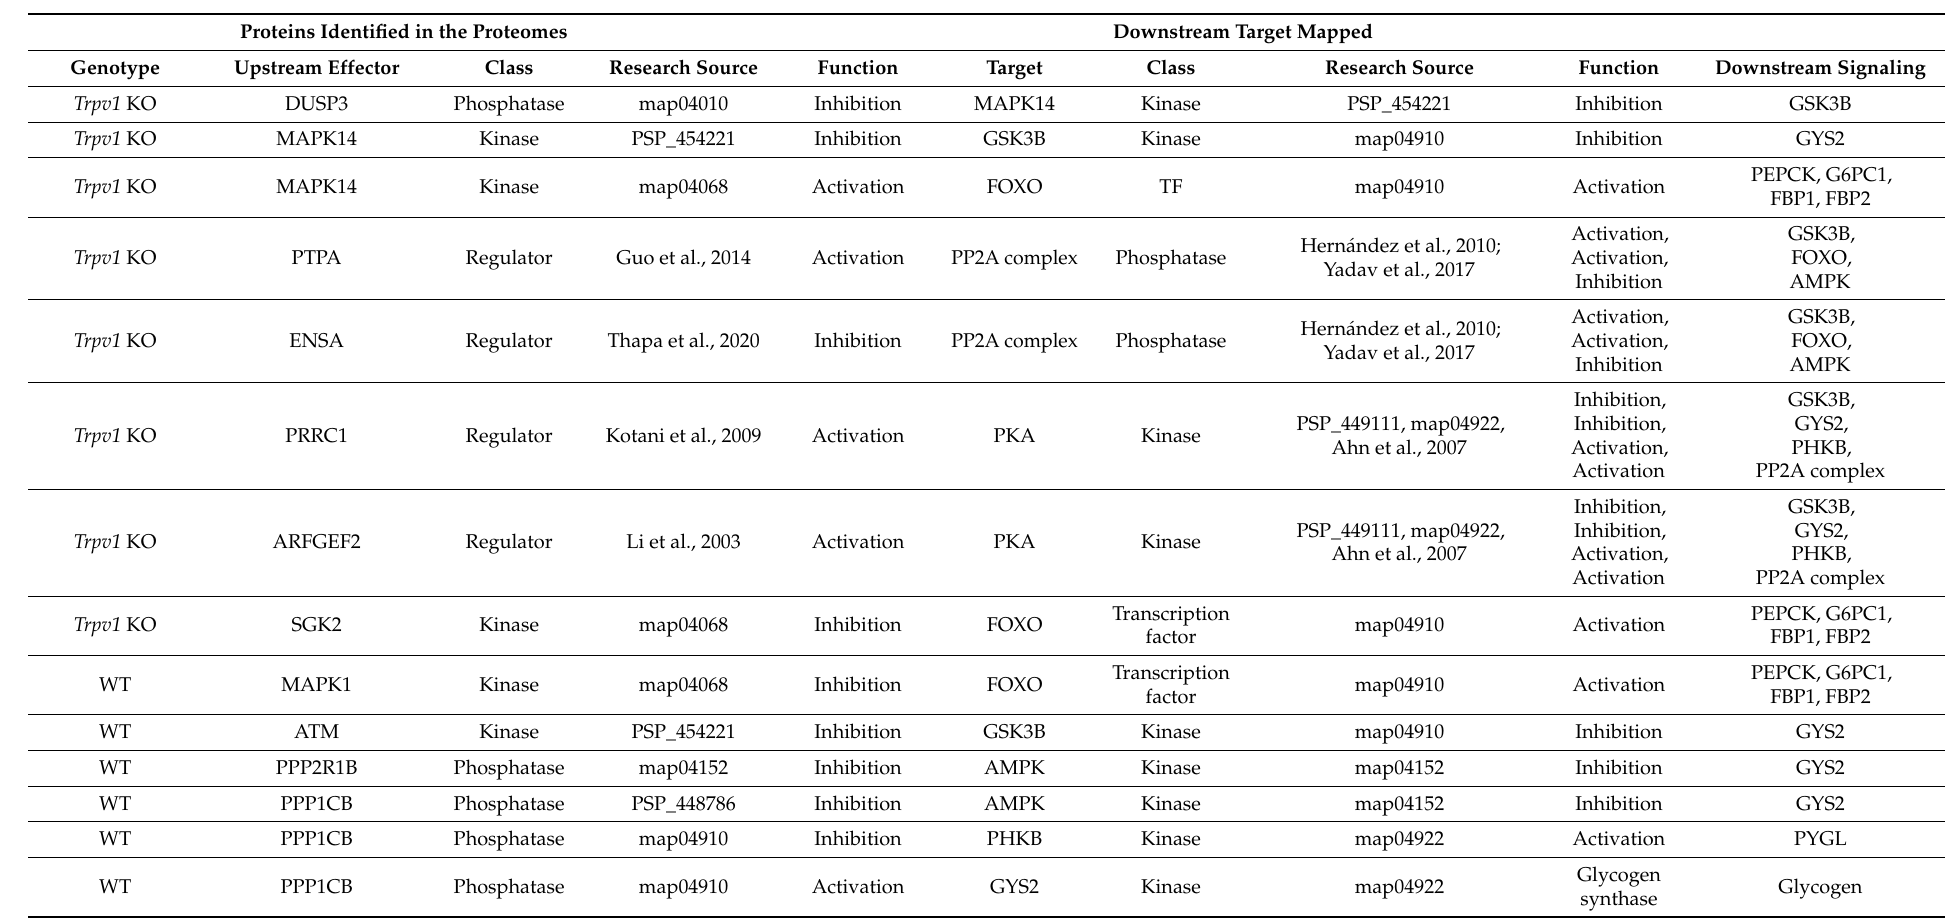
Table 2. List of 11 exclusively identified kinases, phosphatases, and associated regulator proteins reported to be upstream effectors in each proteome and their correspondingly mapped targets, followed by downstream signaling involved in glycogenesis and glycogenolysis. Proteins Identified in the